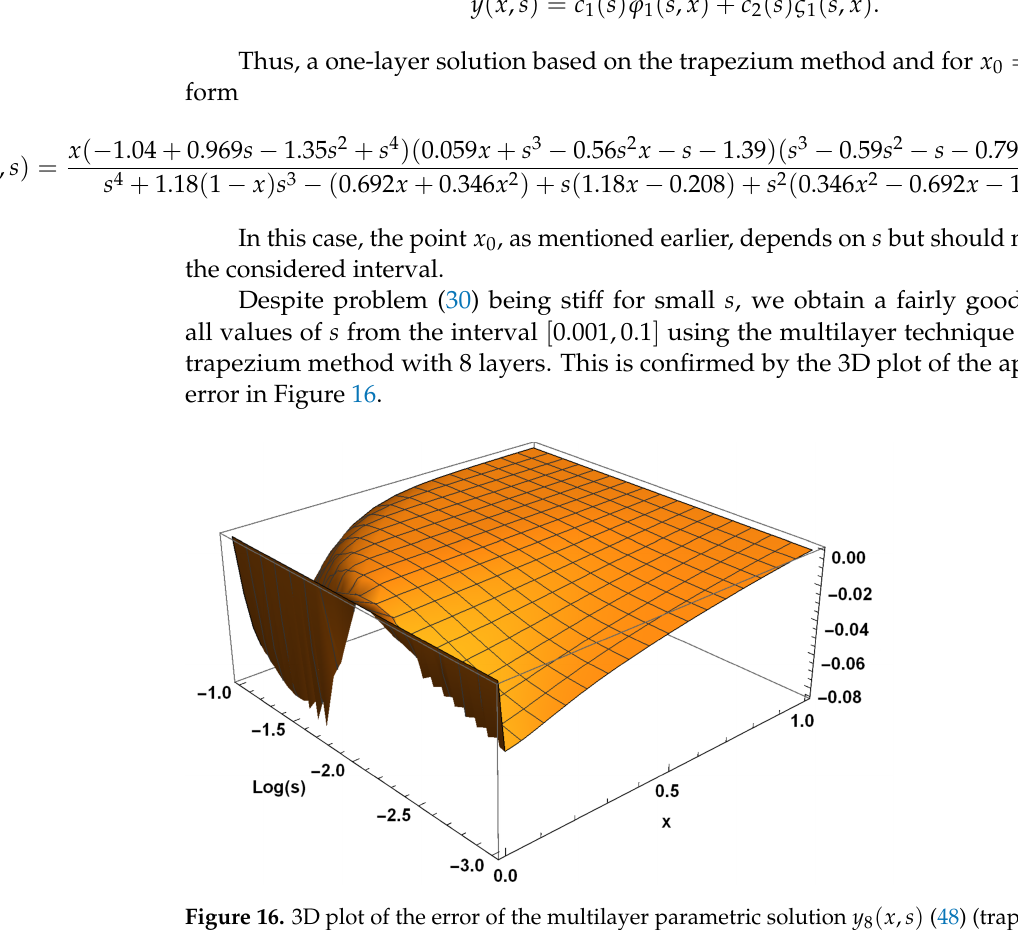
Figure 16. 3D plot of the error of the multilayer parametric solution y 8 ( x , s ) (48) (trapezium method; number of layers n = 8; initial point x 0 = max ( 5 s ,1 ) ) as applied to problem (30), with respect to x ∈ [ 0,1 ] and log ( s ) , s ∈ [ 0.1,0.001 ]